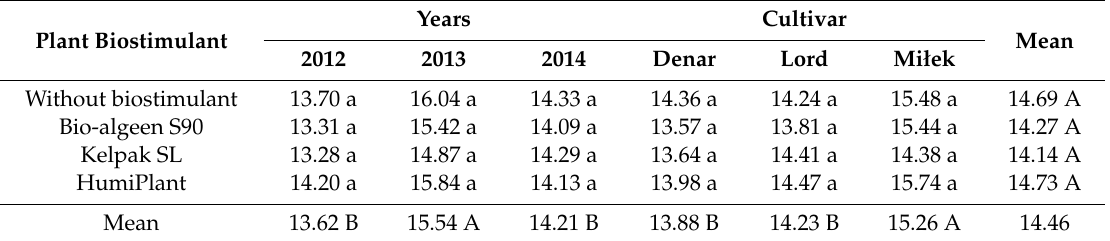
Table 6. Protein content in potato tubers; g · kg − 1